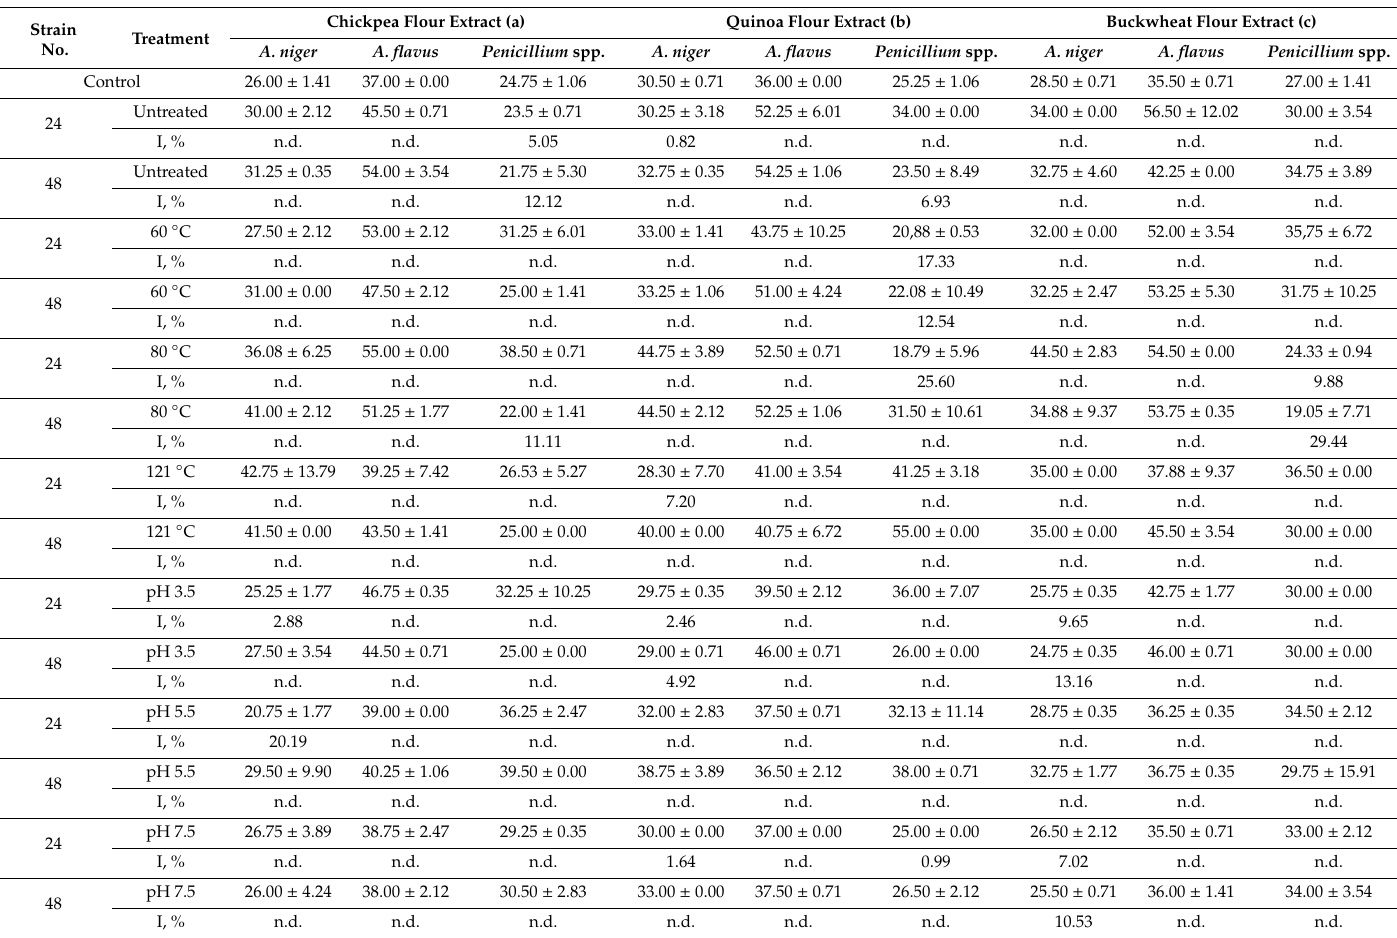
Table 4. Antifungal activity of fermented ( a ) chickpea, ( b ) quinoa, and ( c ) buckwheat extracts after undergoing thermal and acidification treatments. The fermentations were carried out throughout 72 h at 37 ◦ C with Lactobacillus spp. no. 24 and Leuconostoc spp. no. 48. Strain